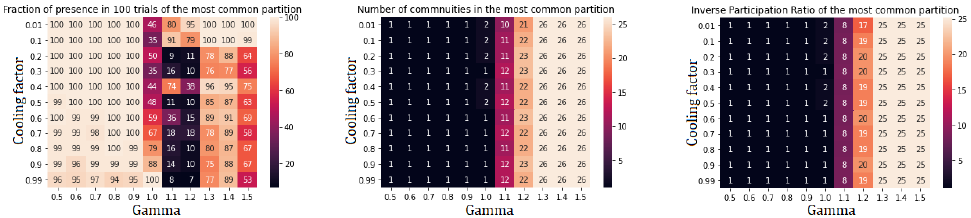
Figure A5. Performance indicators for Spin Glass algorithm applied to community II. There is no further subdivision.